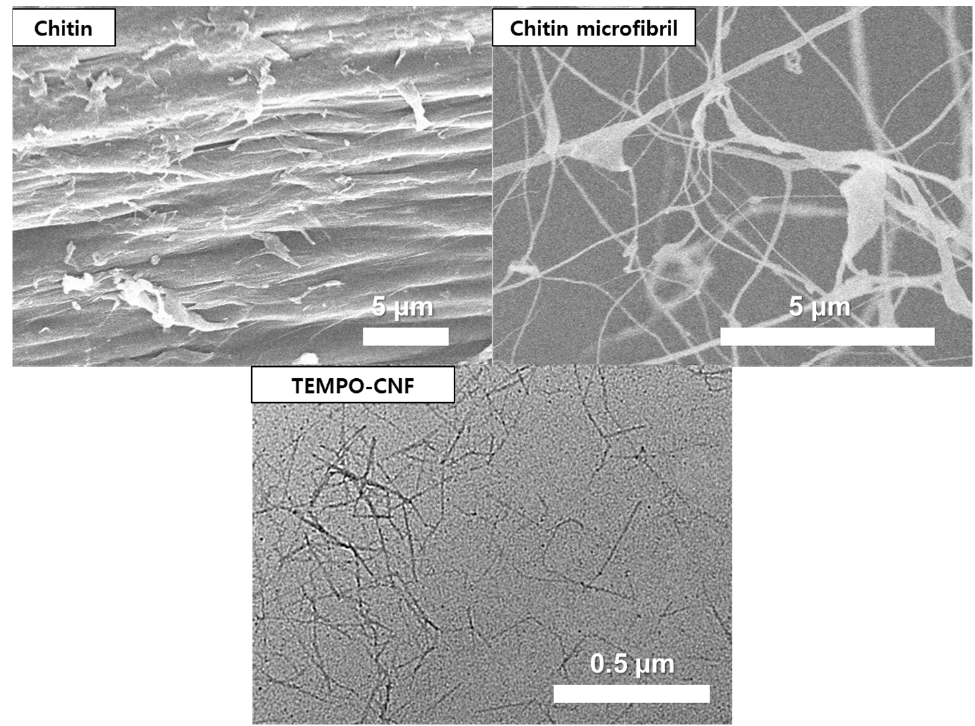
Figure 1. The SEM images of the chitin, chitin microfibril produced from it, and the TEM image of TEMPO-CNF.